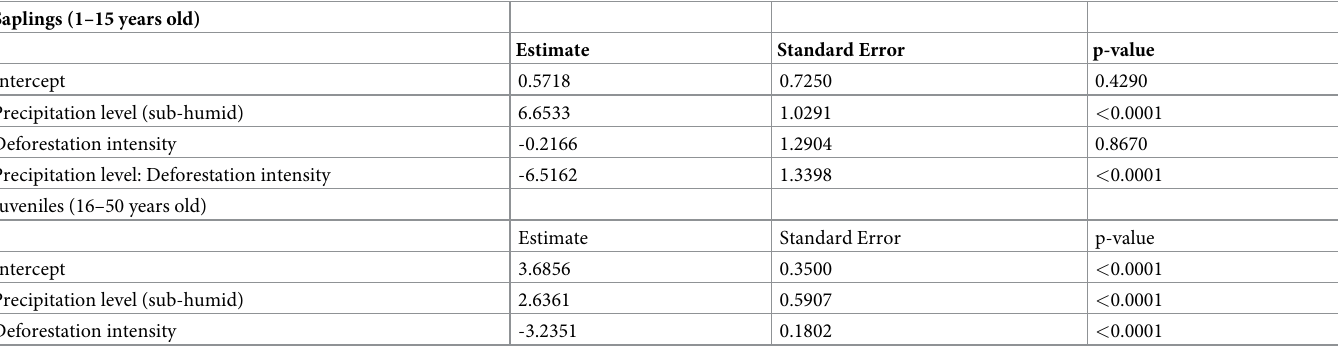
Table 1. Parameter estimates from the best fitting Poisson regression models of the effect of precipitation level and intensity of past deforestation on the number of recruits of Quercus ilex per plot. Saplings (1–15 years